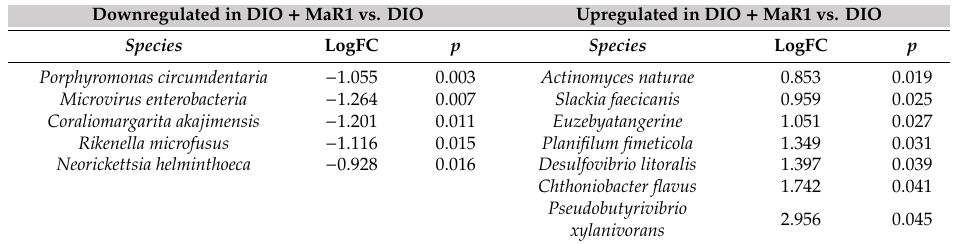
Table 2. Differential bacterial taxonomic profile at the species level in the DIO + MaR1 vs. DIO mice. Downregulated in DIO + MaR1 vs. DIO Upregulated in DIO + MaR1 vs. DIO Species LogFC p Species LogFC p Porphyromonas circumdentaria − 1.055 0.003 Actinomyces naturae 0.853 0.019 Microvirus enterobacteria − 1.264 0.007 Slackia faecicanis 0.959 − 1.201 Neorickettsia helminthoeca − 0.928 0.016 Desulfovibrio litoralis Chthoniobacter flavus